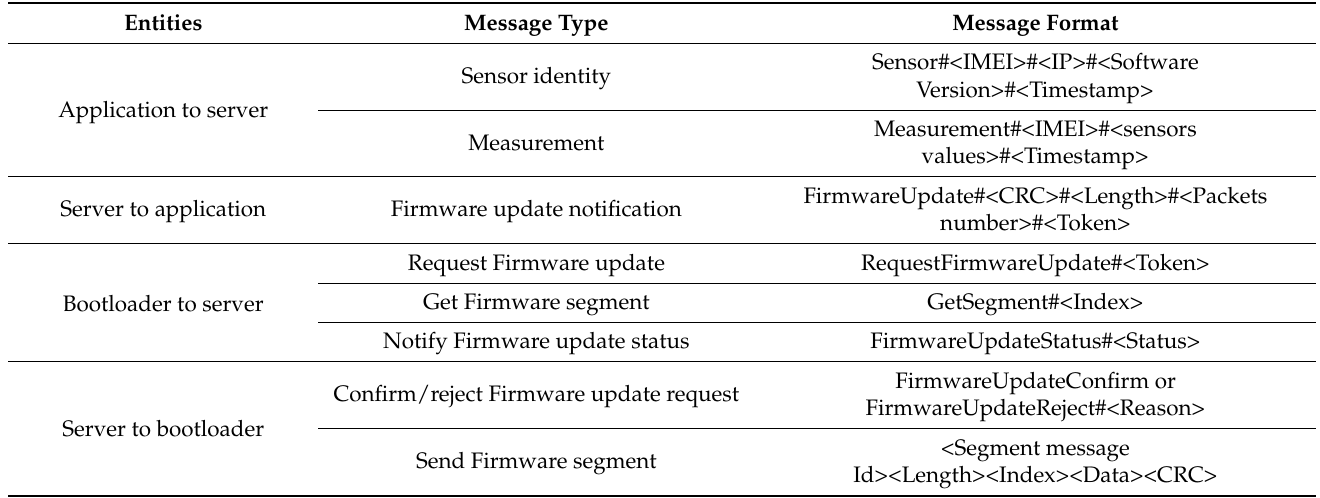
Table 2. NB-IoT Messages Format.